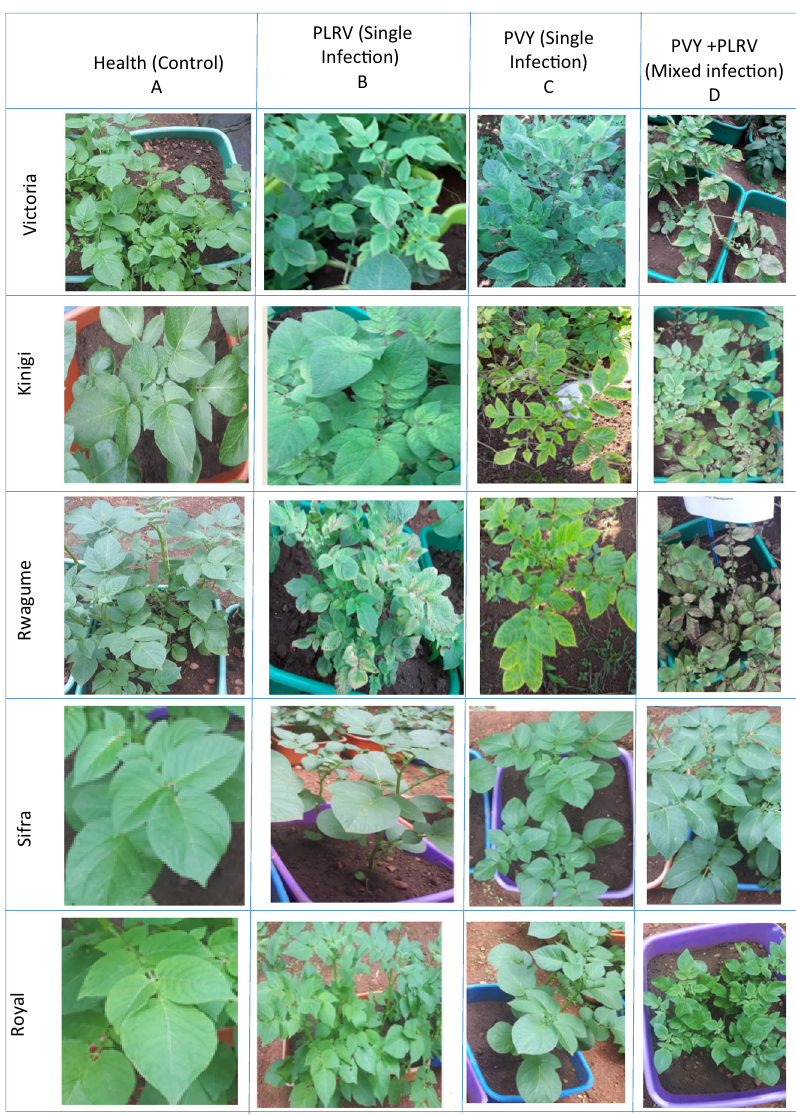
Figure 1: Symptom development caused by PVY and PLRV single infection and mixed